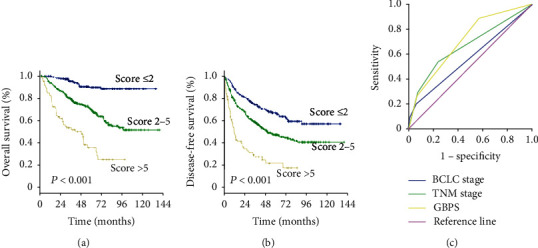
GGT-based prognostic score (GBPS). (a) Overall survival and (b) disease-free survival curves. (c) AUC values for GBPS, TNM stage, and BCLC stage.